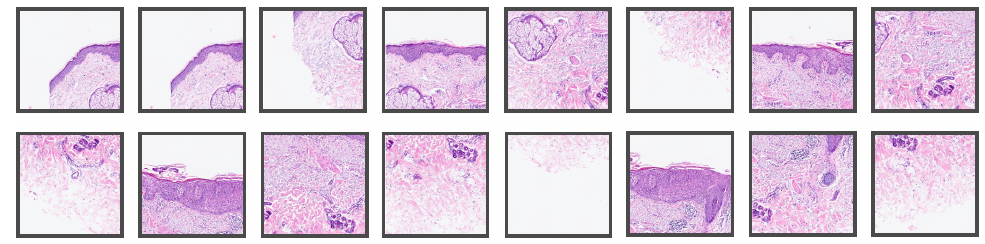
Figure 2. Representative tiles of size 1024µm × 1024µm from the WSI in Figure 1 that were used for evaluating the established algorithm.